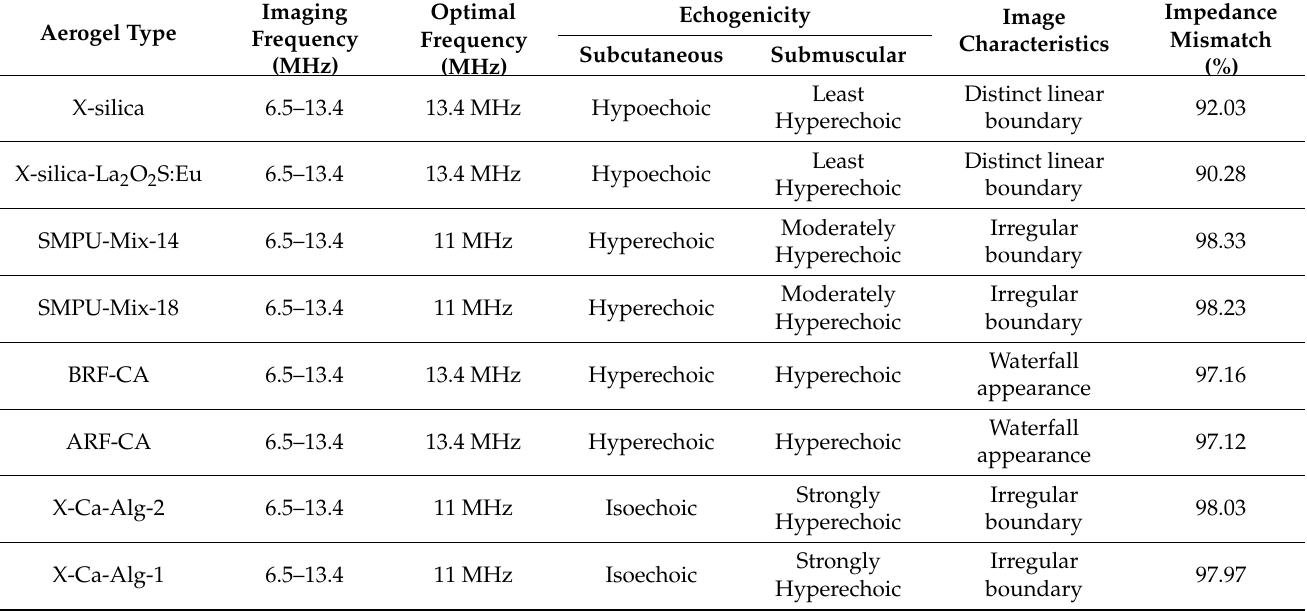
Table 7. Aerogel imaging classifications and image characteristics based upon the optimal frequency,